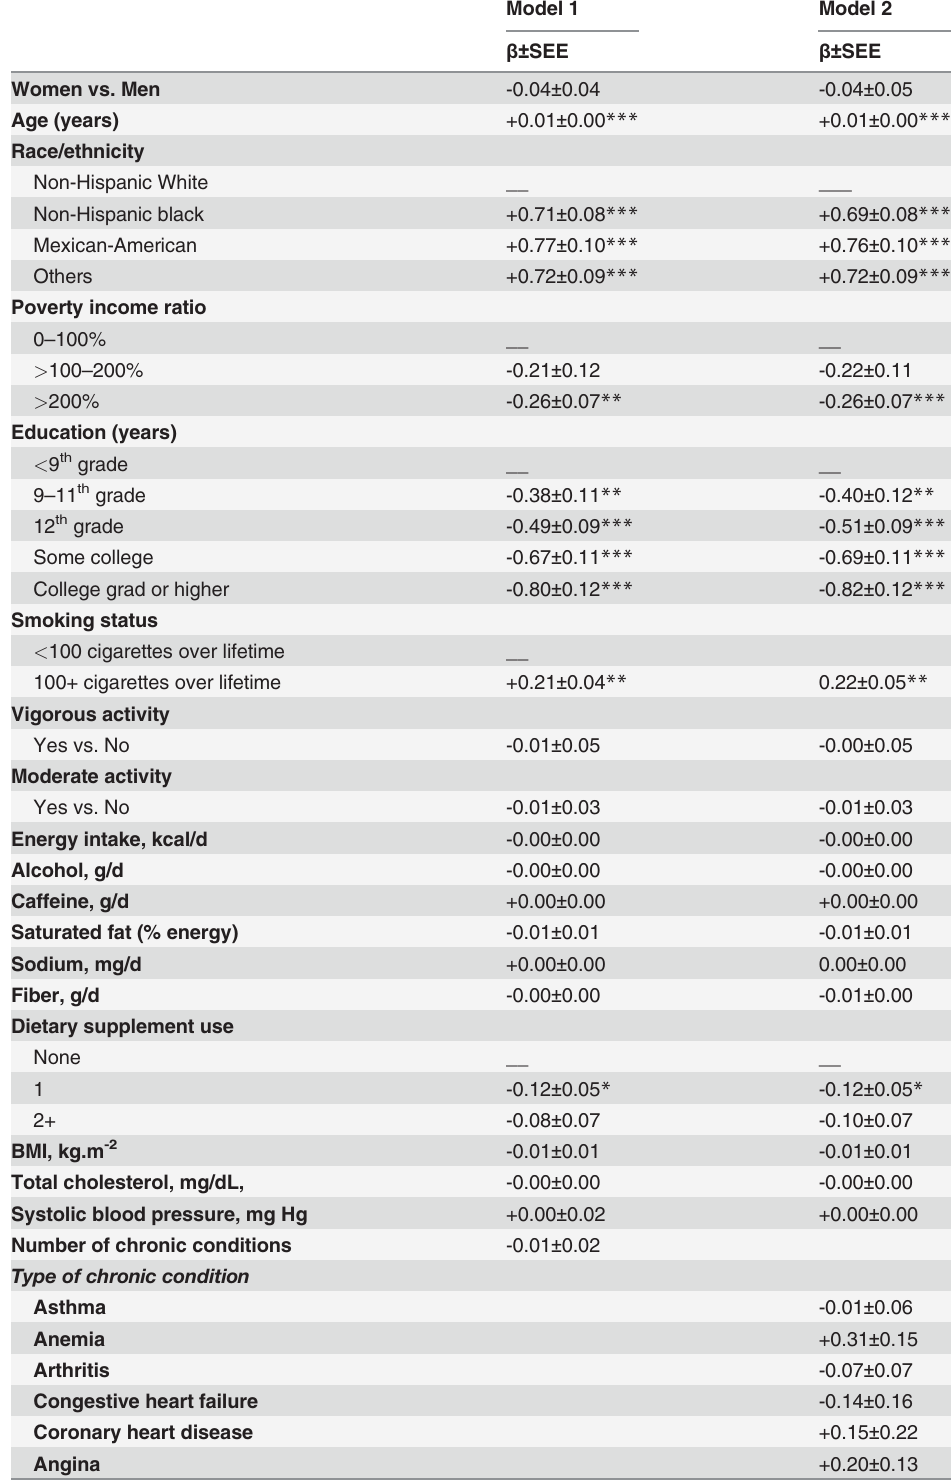
Table 3. Hp s (Log e transformed) in relation to selected factors, ordinary least squares multiple regres- sion models: NHANES 1999 – 2000 (N =